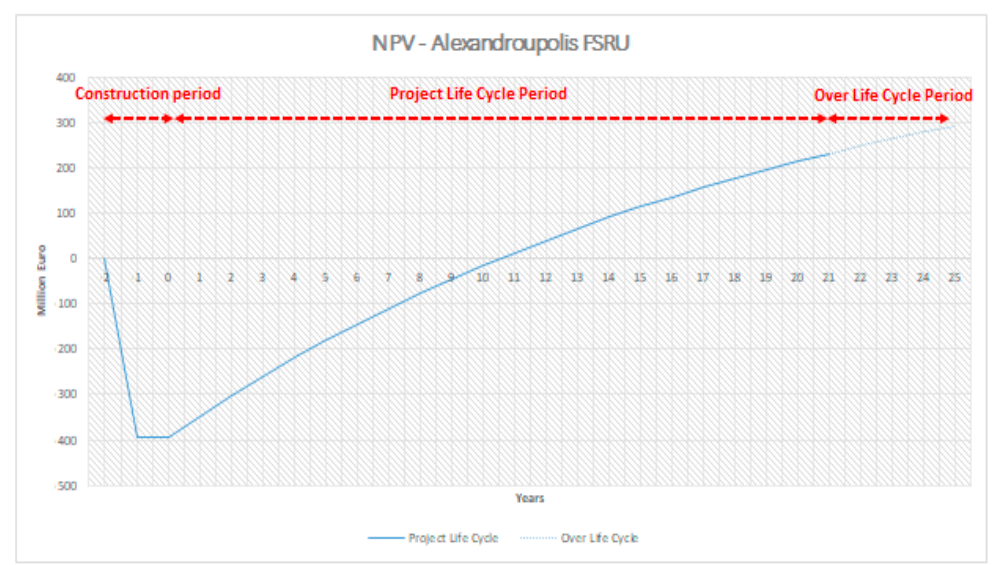
Figure 2. NPV for the Alexandroupolis FSRU Project.